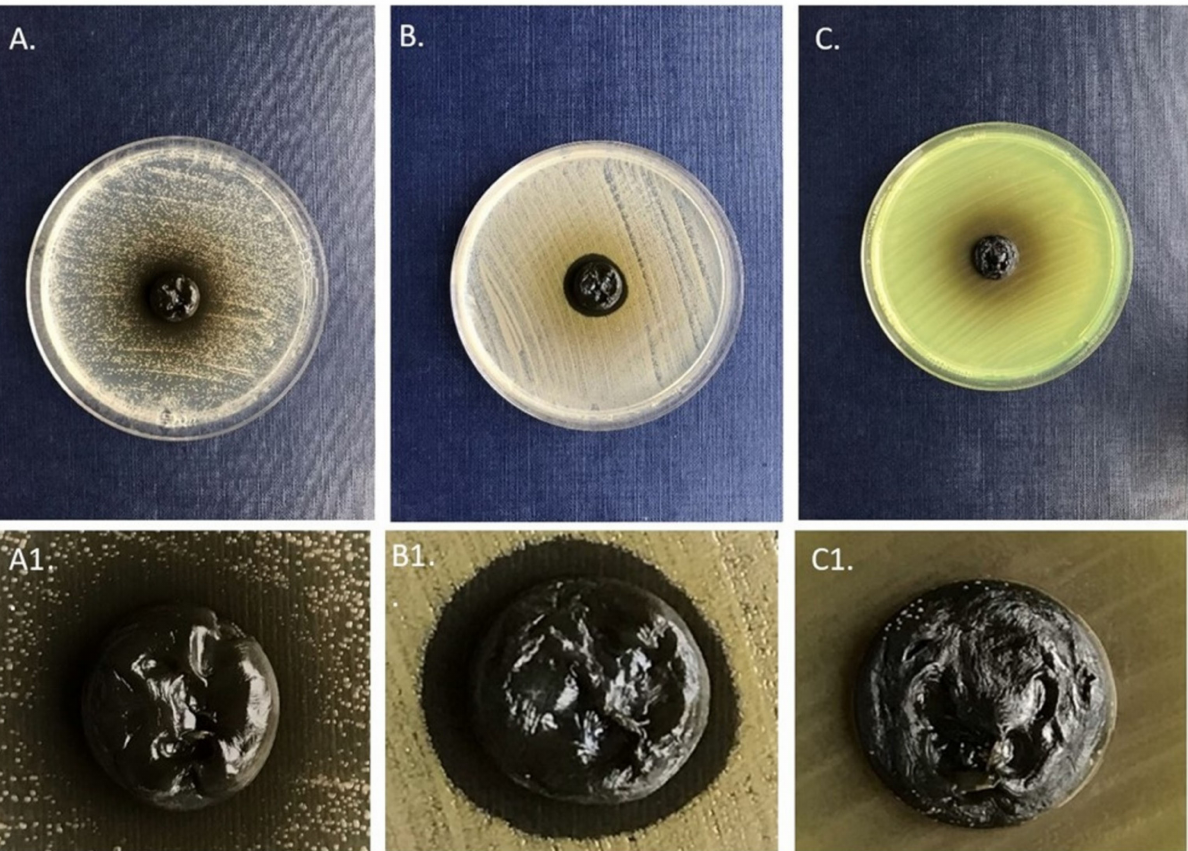
Figure 2. Zones of the inhibition of growth of ( A ) C. albicans and ( B ) S. aureus as the result of the release of the C. cheilanthifolia herb extract from the BC carrier. Please note that in the case of ( C ) P. aeruginosa , no inhibition zone was observed despite visible release (oval zone of dark color) of extract from the BC carrier. Pictures ( A1 – C1 ) are at 3x magnification of the BC carriers and inhibition zones (in the case of picture ( A1 , B1 ), and lack of zone in the case of ( C1 )) from pictures ( A – C ),